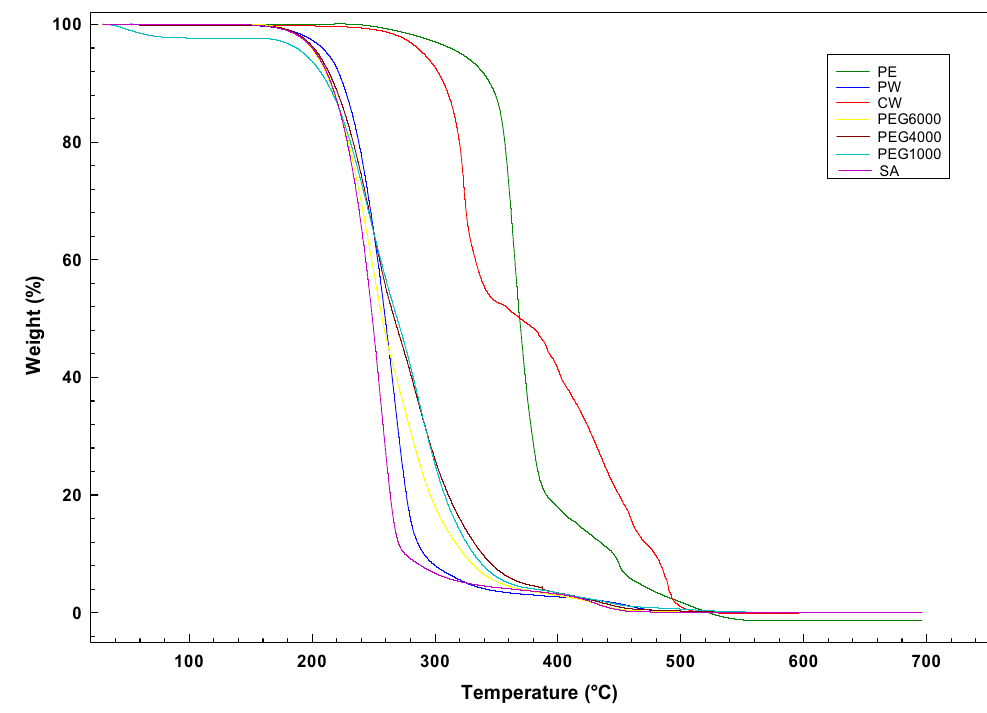
Figure A1. TGA weight loss curves for binders